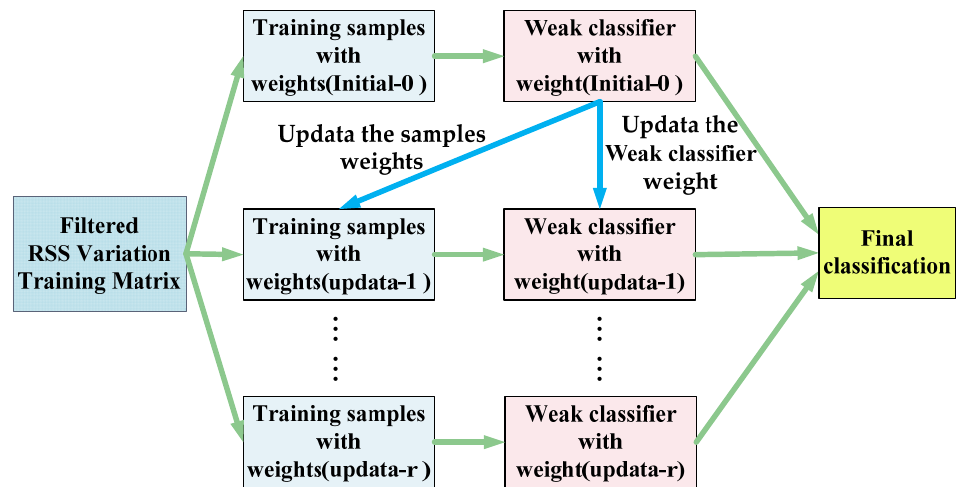
Figure 6. The schematic diagram of the ensemble learning model.